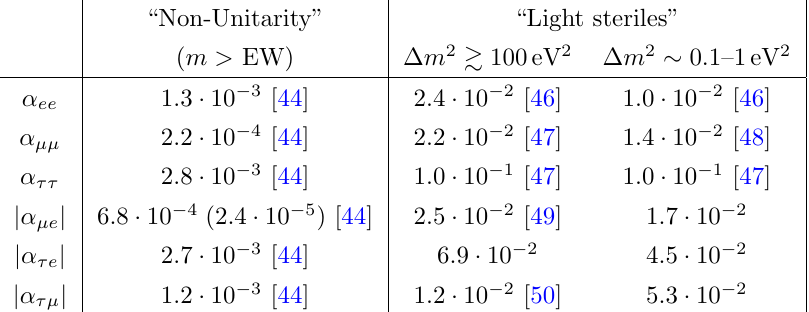
Table 1 . Current upper bounds on the (cid:11) parameters in the scenarios considered in this work. The limits are shown at 2 (cid:27) and 95% C.L. (1 d.o.f.) for the non-unitarity and light sterile neutrino scenarios. The bounds in the middle column apply for (cid:1) m 2 & 100 eV 2 and will thus be relevant when the sterile neutrino oscillations are in the averaged-out regimes for both the near and far detectors of most long-baseline experiments. The bounds in the right column apply for (cid:1) m 2 (cid:24) 0 : 1{ 1 eV 2 and will thus be relevant when the sterile neutrino oscillations are in the averaged-out regime for the far detector, but not for the near detector. The second number quoted in parenthesis for the (cid:11) (cid:22)e element includes the (cid:22) ! e(cid:13) observable, which can in principle be evaded [45], see main text for details. The numbers for the o(cid:11)-diagonal parameters without a reference are obtained indirectly p from constraints on the diagonal parameters via (cid:11) (cid:11)(cid:12) (cid:20) 2 (cid:11) (cid:11)(cid:11) (cid:11) (cid:12)(cid:12) (see eq. (3.5)). See appendix A for further